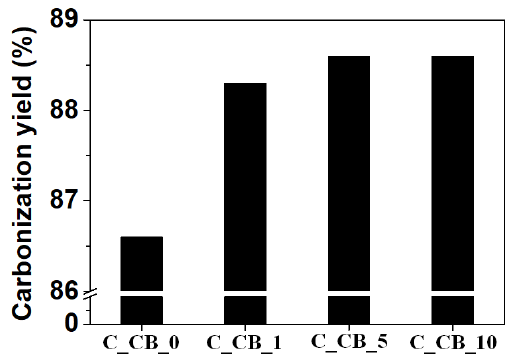
Figure 4. The carbonization yield of carbon blocks according to the added CB amount.